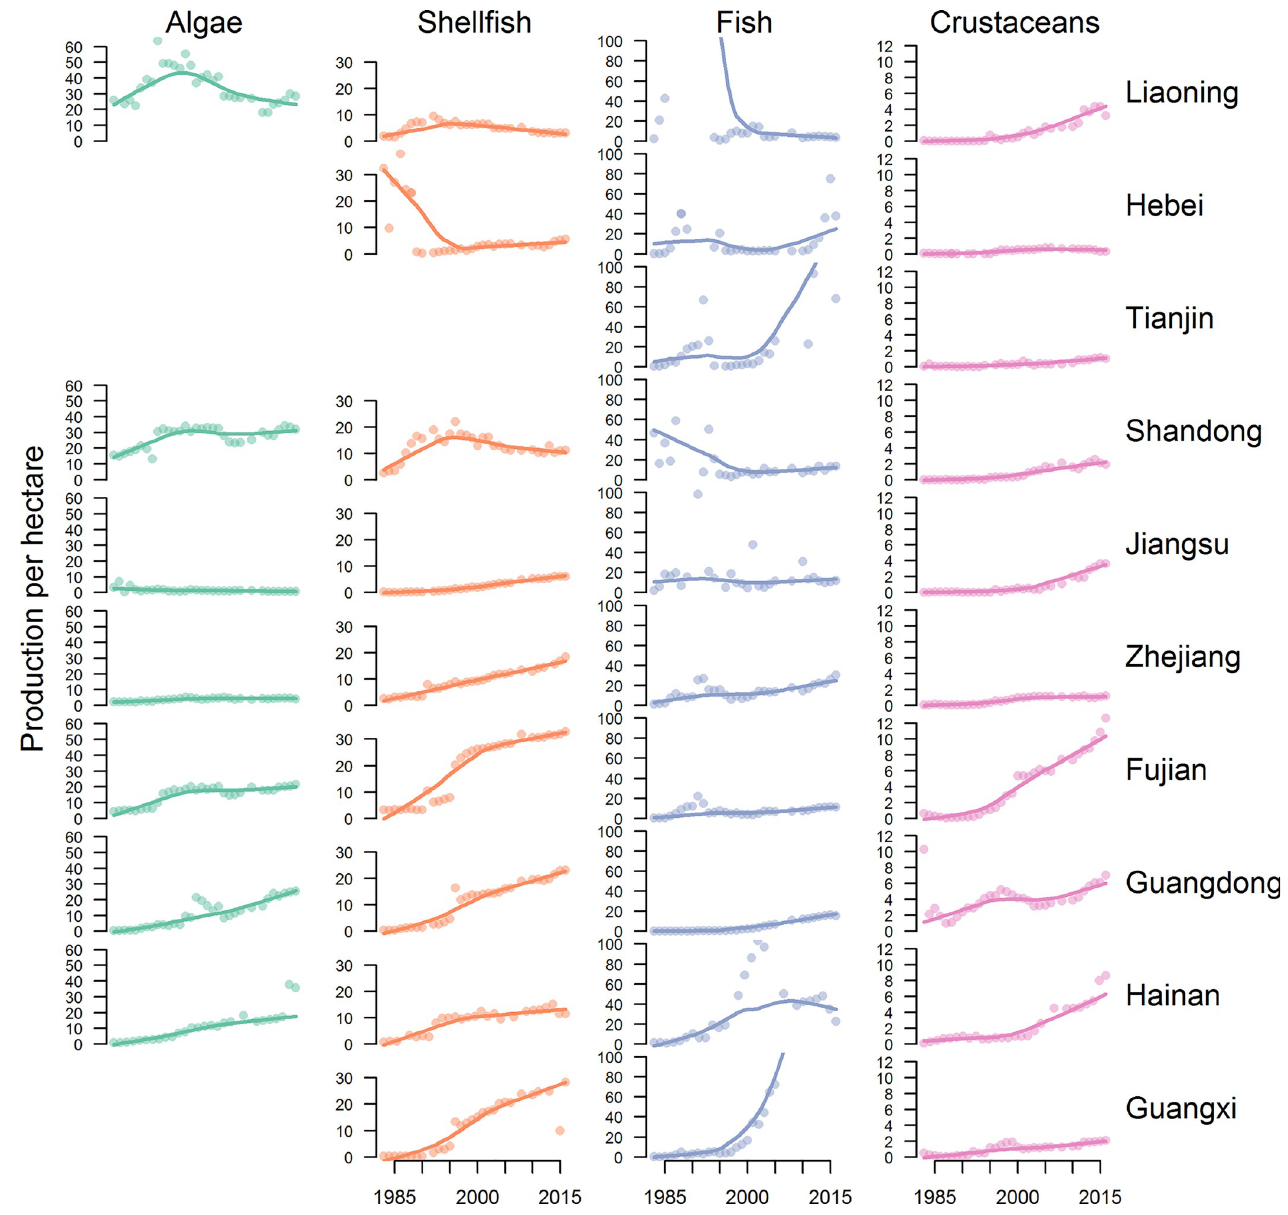
Fig 9. Production per hectare of mariculture products over time by province with LOESS line overlaid.